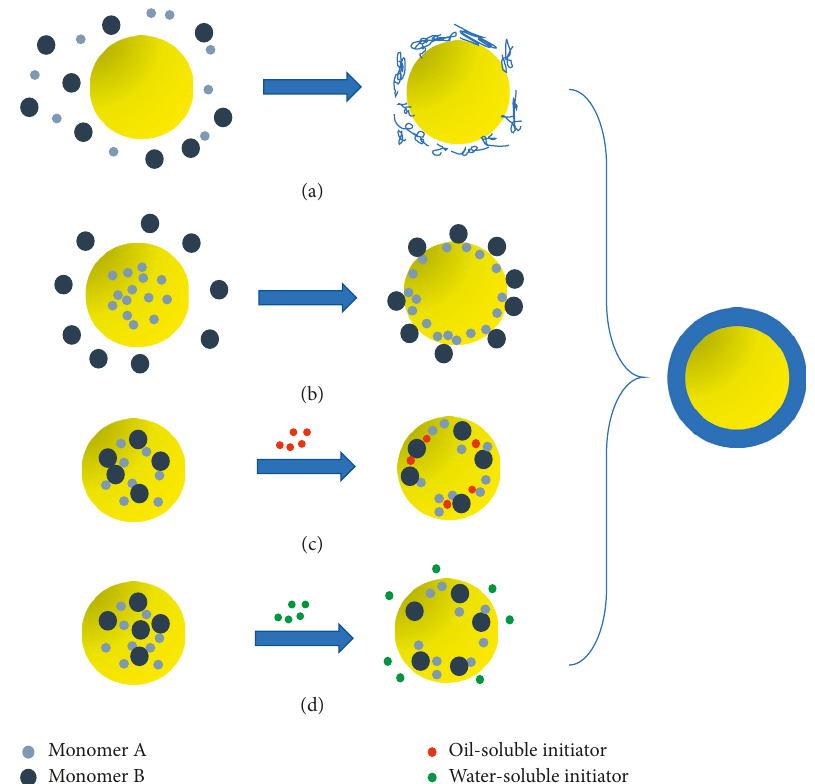
Figure 4: Schematic diagrams of various chemical microencapsulation methods: (a) in situ polymerization, (b) interfacial polymerization, (c) suspension polymerization, and (d) emulsion